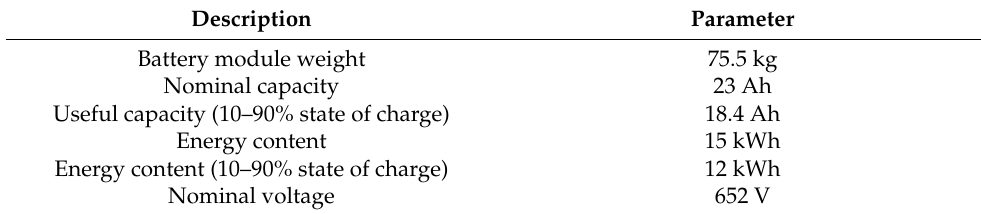
Table 6. On-board trolleybus battery specifications.